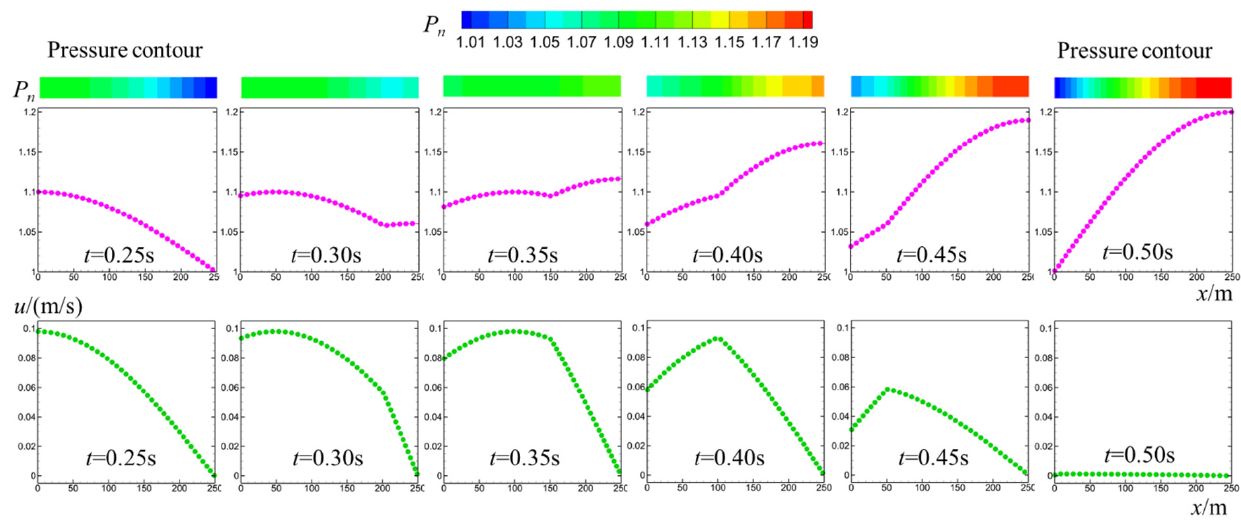
Figure 15. Normalized pressure–position P n - x curves (upper part) and velocity–position u - x curves (lower part) during 0.25 pulse-periods from t = 0.25 s to t = 0.5 s, where L x = 250 m and f = 1 Hz. The velocity is not zero at t = 0.25 s (shown in the lower left).